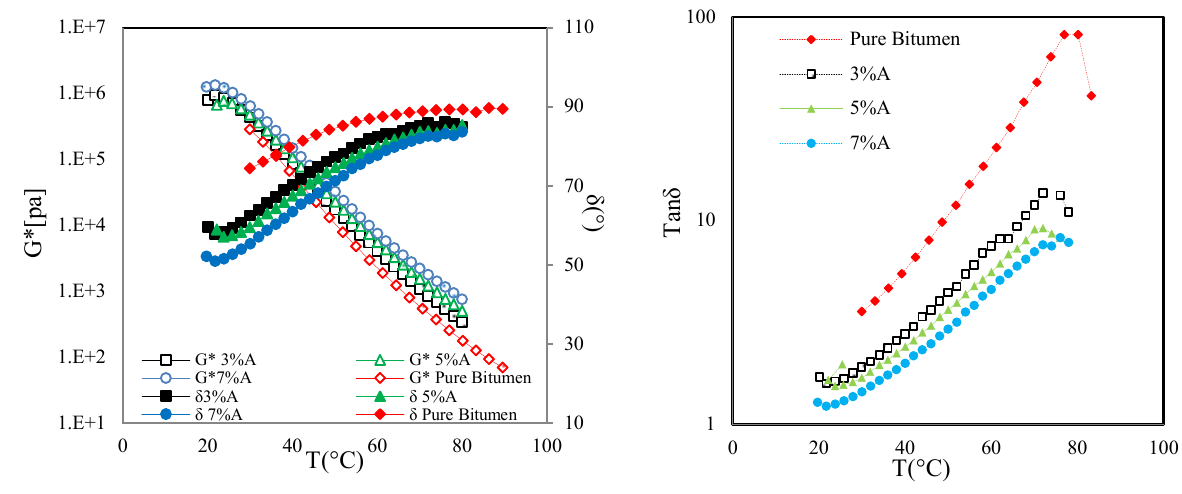
Fig. 1. Complex modulus/phase angle (left) and Tanδ (right) curves for the bitumen modified by blend A.